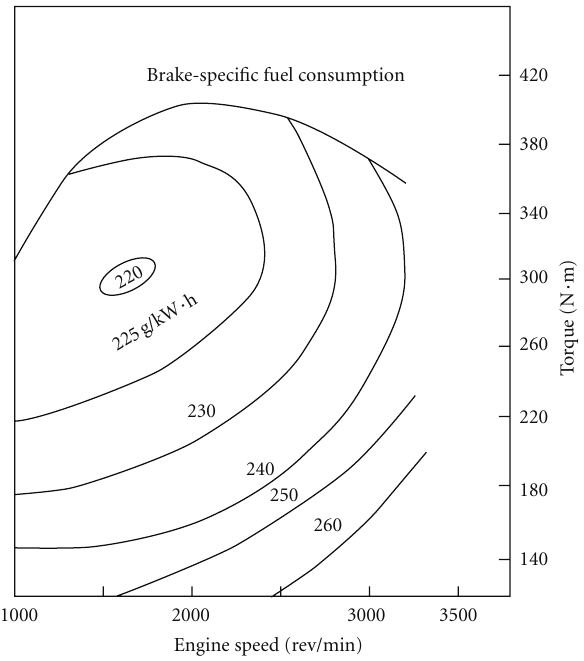
Figure 1: An example of diesel engine performance map